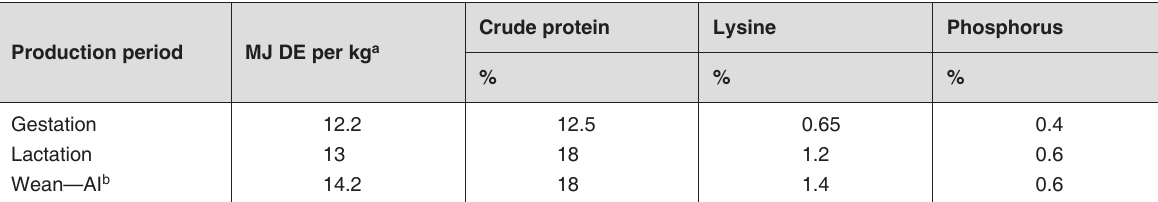
TABLE 1 Diet composition for breeding sows in different production periods. No antibiotics were added